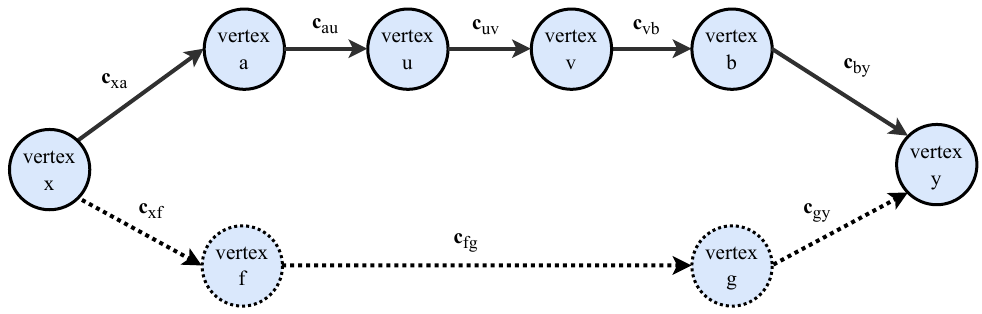
Figure 3. Multi-objective dynamic shortest path graph example where the dashed lines represent vertices and edges added at an unpredictable moment. The vertices are named by the letters x , a , u , v , b , f , g , and y , being x the source vertex and y the destination vertex. Vector c over the edge represents the edge traverse multi-objective cost between two